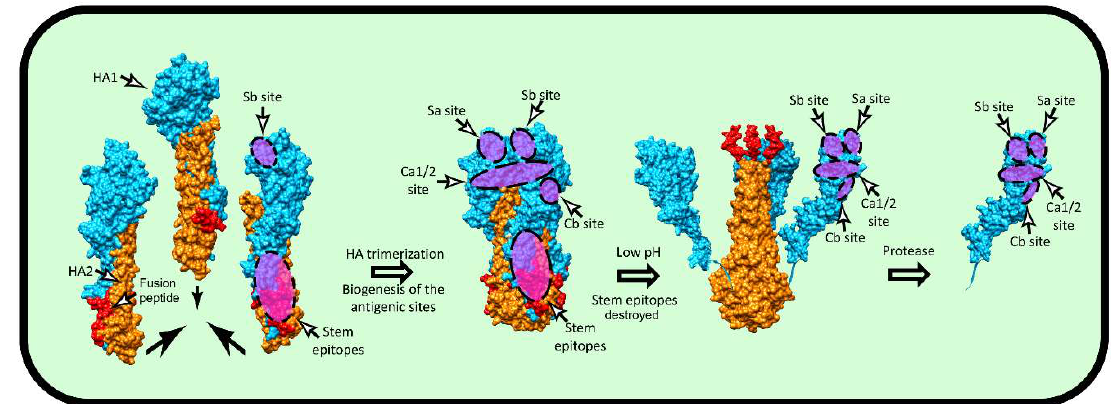
Figure 4. Biogenesis of HA antigenic sites. The HA head antigenic site Sb and HA stem protective epitopes are formed on HA monomers during biogenesis, while for other sites on the HA head, full maturation requires HA trimerization. Contrary to HA stem epitopes, which are destroyed by conformational changes triggered by low pH, HA head antigenic sites are remarkably resistant and remain intact even after proteolytic liberation of the monomeric head domain. The pdb entries 1htm, 1ibn, and 2vir (A/Aichi/2/1968 H3N2) were used to visualize various conformational stages during the fusion process. The HA1 is colored bright blue, HA2 orange, and fusion peptide red. Approximate localization of the canonical antigenic sites and the HA stem epitopes are highlighted by translucent purple with dashed edges. UCSF Chimera 1.13 software was used to visualize the molecules.